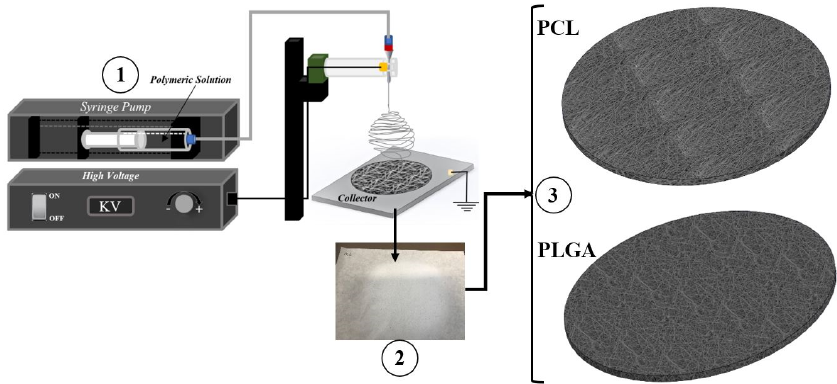
Figure 1. Schematics of the production of flat sheet electrospun scaffolds (1) Syringe pump and power source, (2) collector, (3) electrospun sheet Table 1. Electrospinning process parameters that were recorded during the experiment.